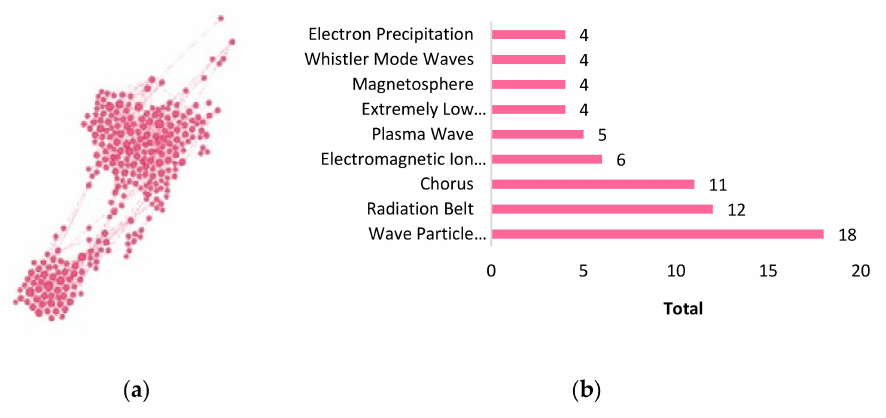
Figure 11. Representation of natural ELF phenomena community: ( a ) isolated distribution of publications, ( b )